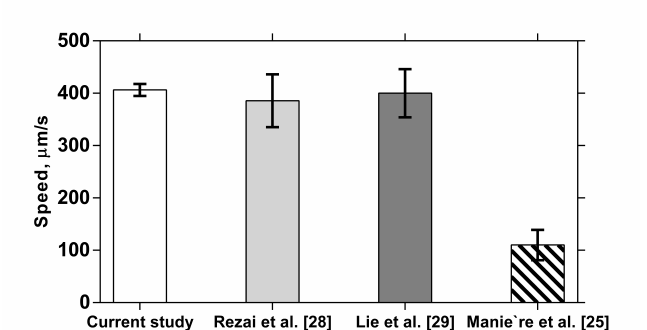
Figure A1. Comparison of the swimming speeds obtained using the multi-worm assay in the current study, and the single worm electrotaxis assays from Rezai et al. [28] and Liu et al. [29], plus the off-chip crawling electrotaxis speed on agar surfaces from Manie ‘re et al.